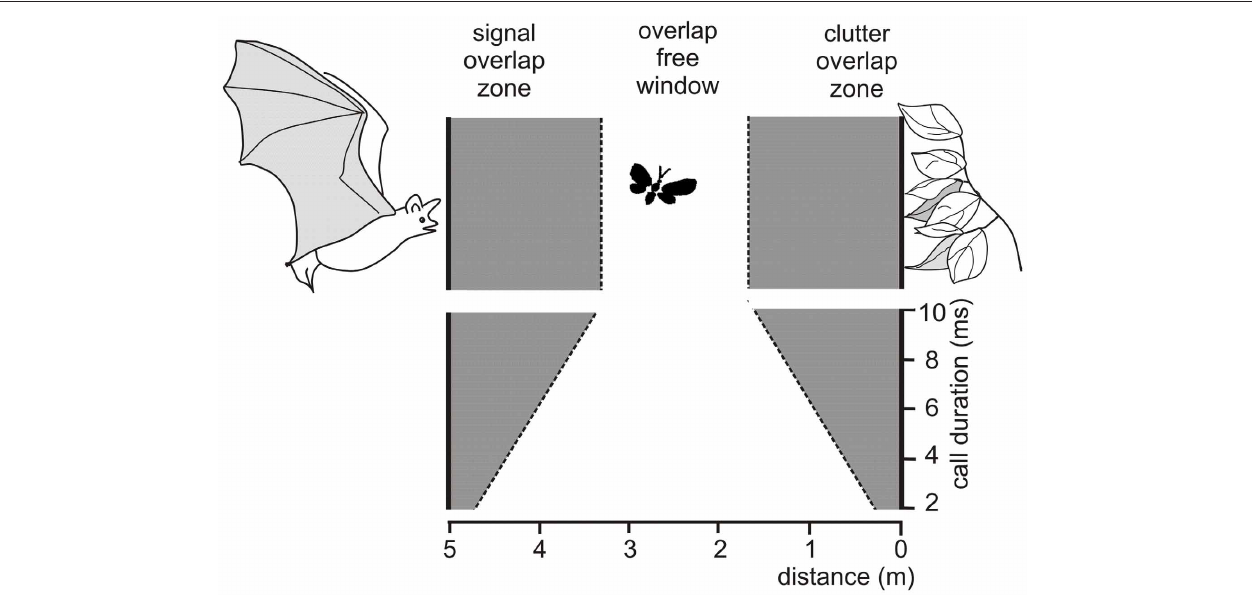
FIGURE 1 | Schematic drawing illustrating the conditions for overlap between emitted signal, prey echo and background echoes a bat encounters when foraging at a distance of 5m to vegetation. The prey echo overlaps with the emitted signal when an insect flies in the signal overlap zone and with the clutter echoes from the background when it flies in the clutter overlap zone. In the overlap-free window no